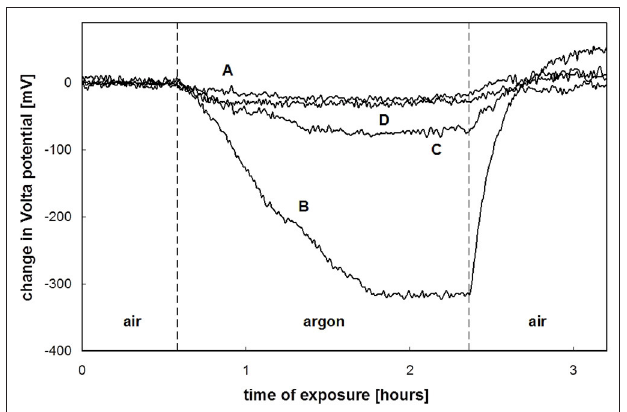
FIGURE 12 | Air-argon-air SKP potential (mV vs. SHE) transients for zinc surfaces treated with vanadate-phosphate conversion coatings. (A) untreated (passive), (B) treated in a 100mM NaCl solution, (C) treated in a 100mM NaCl solution with magnesium phosphate, (D) treated in the presence of magnesium vanadate, magnesium phosphate, and magnesium hydroxide in a 100mM NaCl solution. Reproduced with permission from Nazarov et al. (2005) Copyright 2005, The Electrochemical Society.